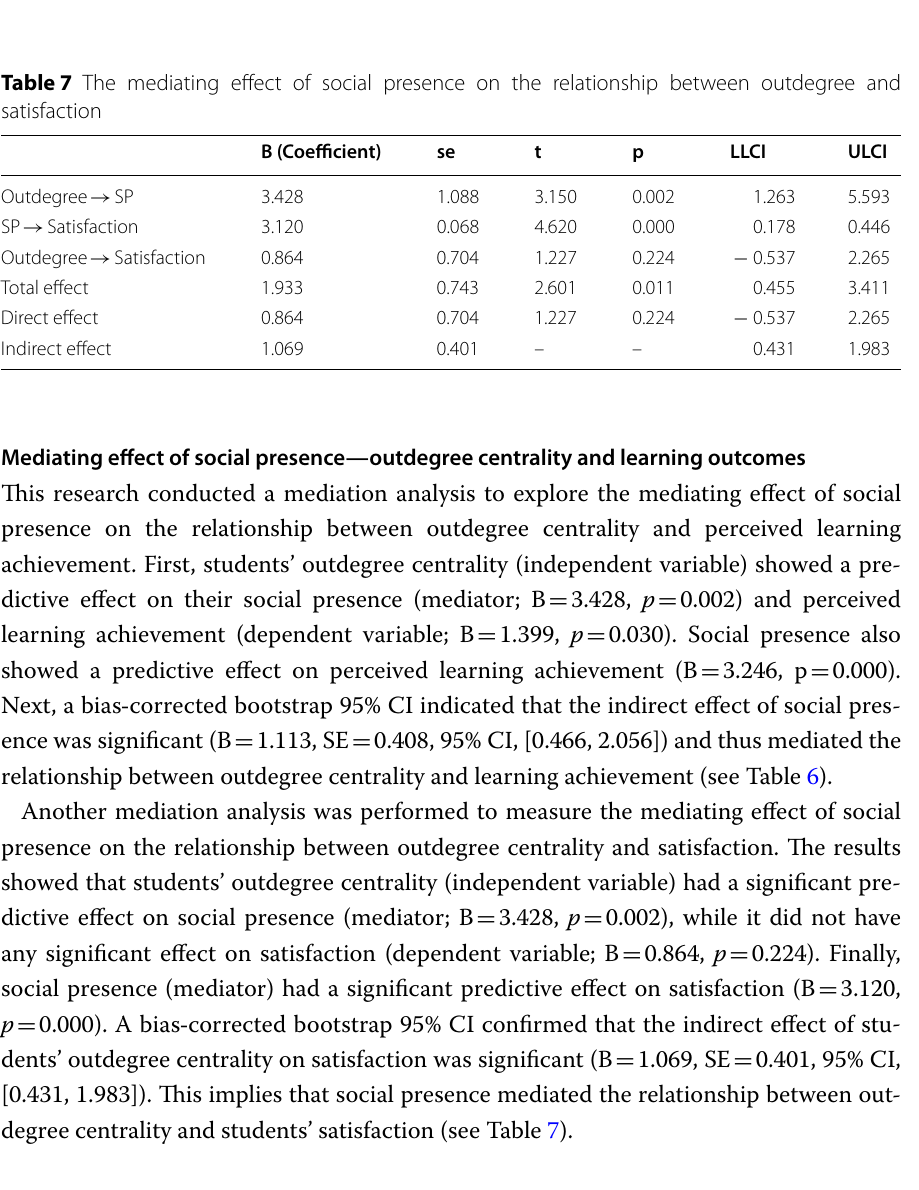
Table 7 The mediating effect of social presence on the relationship between outdegree and satisfaction